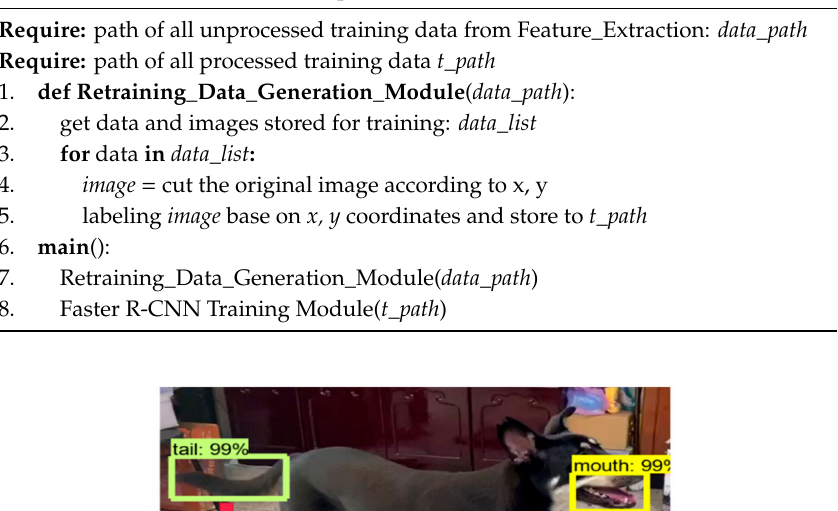
Algorithm 6 Model_Automatic_Optimization_Module